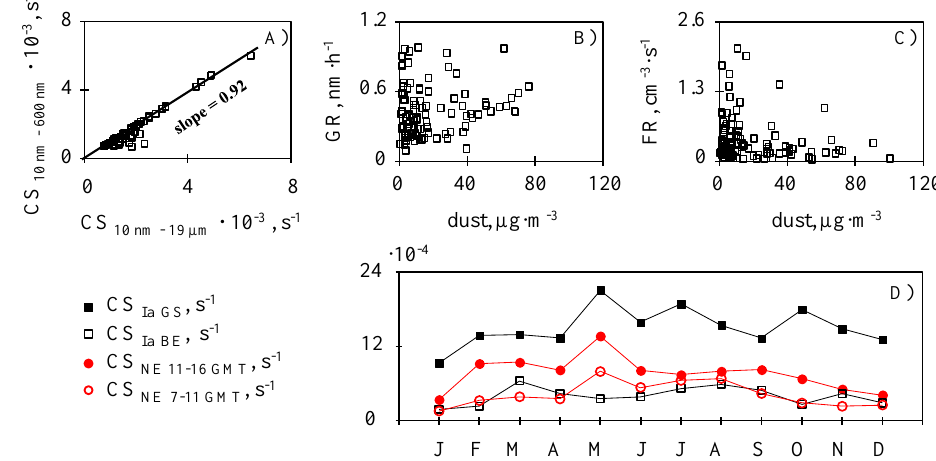
Fig. 10. (A) CS 10–600nm versus CS 10nm–19µm , (B–C) Scatter plots of the formation rates (FR) and growth rates (GR) versus dust concen- tration at Izaña during the NPF events (type Ia), (D) comparative analysis of the CS during NPF events and during non-events. Monthly means of CS during two stages of the NPF event: (i) at the start of the NPF and (ii) during the growth step. Similarly, it is shown at two periods during non-events: (i) 07:00–11:00GMT ( ∼ start time during NPF) and (ii) 11:00–16:00GMT ( ∼ typical time of the growth step during